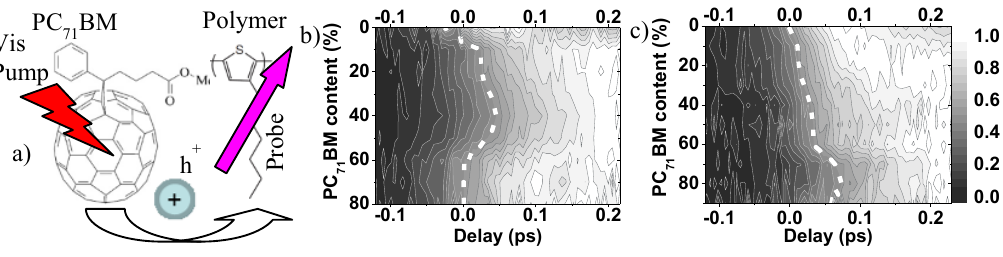
Fig.1. The schematics of photophysical processes following fullerene excitation (a).Polaron response as a function of time at different fullerene weight content for MDMO-PPV:PC 71 BM (b) and P3HT:PC 71 BM (c). The greyscale scheme shown on the right represents induced absorption of each transient normalized to 1. Contour lines are drawn with 5% step of maximal amplitude. Dashed curves show the delay where half maximum amplitude is reached.